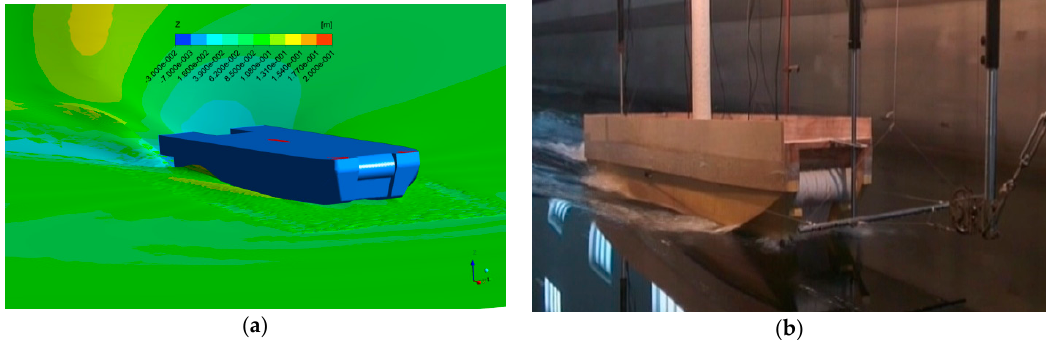
Figure 14. Comparison of numerical and experiment free surface wave making ( Fr = 0.31).